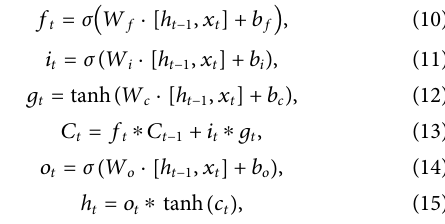
FIGURE 3 The work fl ow Chart of